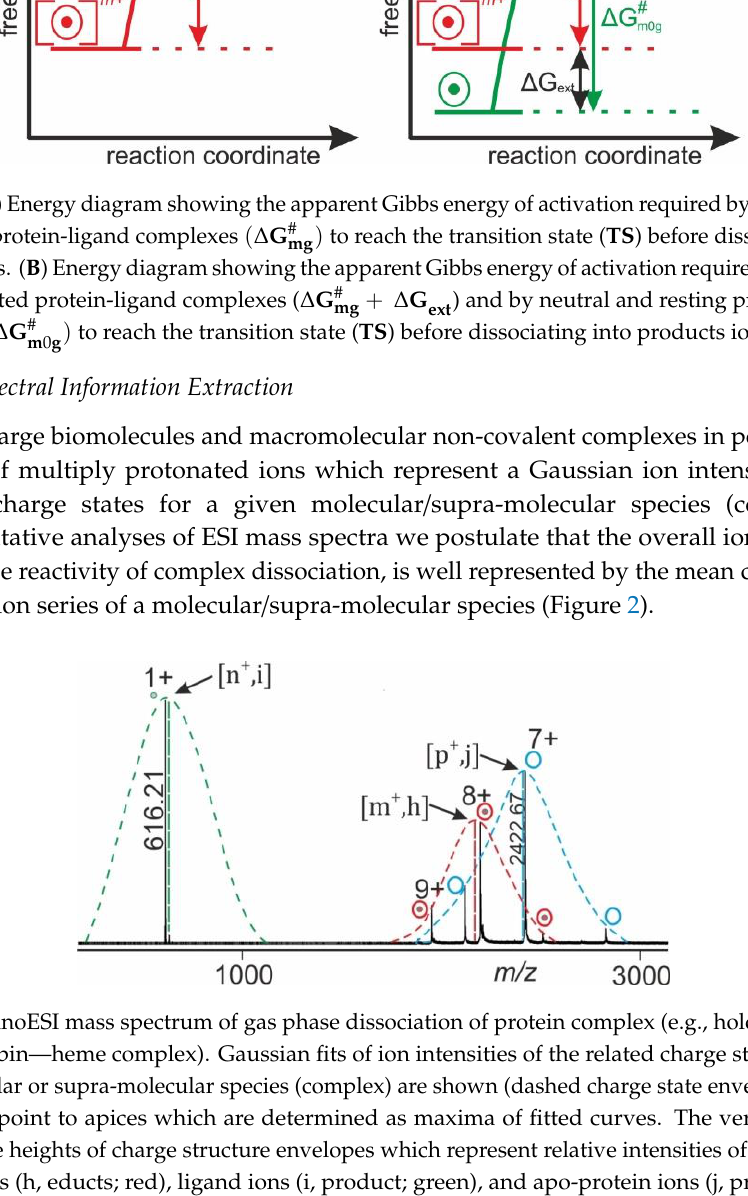
Figure 1. ( A ) Energy diagram showing the apparent Gibbs energy of activation required by charged and accelerated protein-ligand complexes (∆𝐆 𝐦𝐠# ) to reach the transition state ( TS ) before dissociating into products ions. ( B ) Energy diagram showing the apparent Gibbs energy of activation required by charged and accelerated protein-ligand complexes ( ∆𝐆 𝐦𝐠# + ∆𝐆 𝐞𝐱𝐭 ) and by neutral and resting protein-ligand complexes ( ∆𝐆 𝐦𝟎𝐠# ) to reach the transition state ( TS ) before dissociating into products ions.